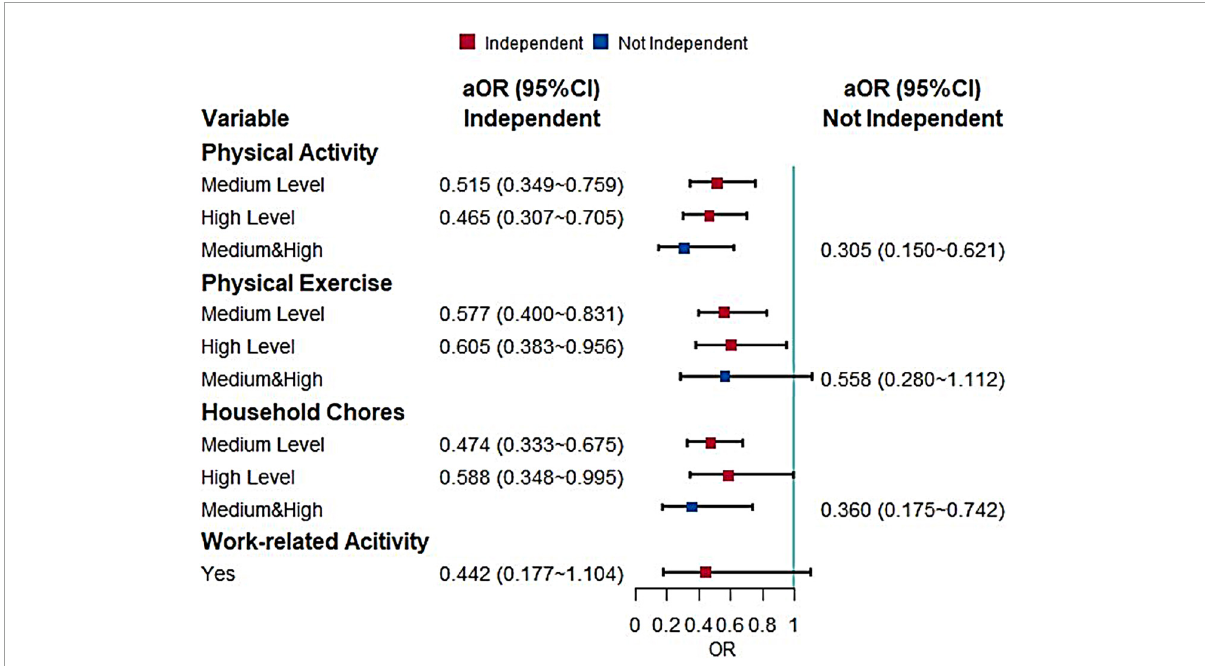
FIGURE3 Effects of different types of physical activity on MCI when stratified by BADL (aOR, adjusted odds ratio; Use the low level and negative response as the reference).